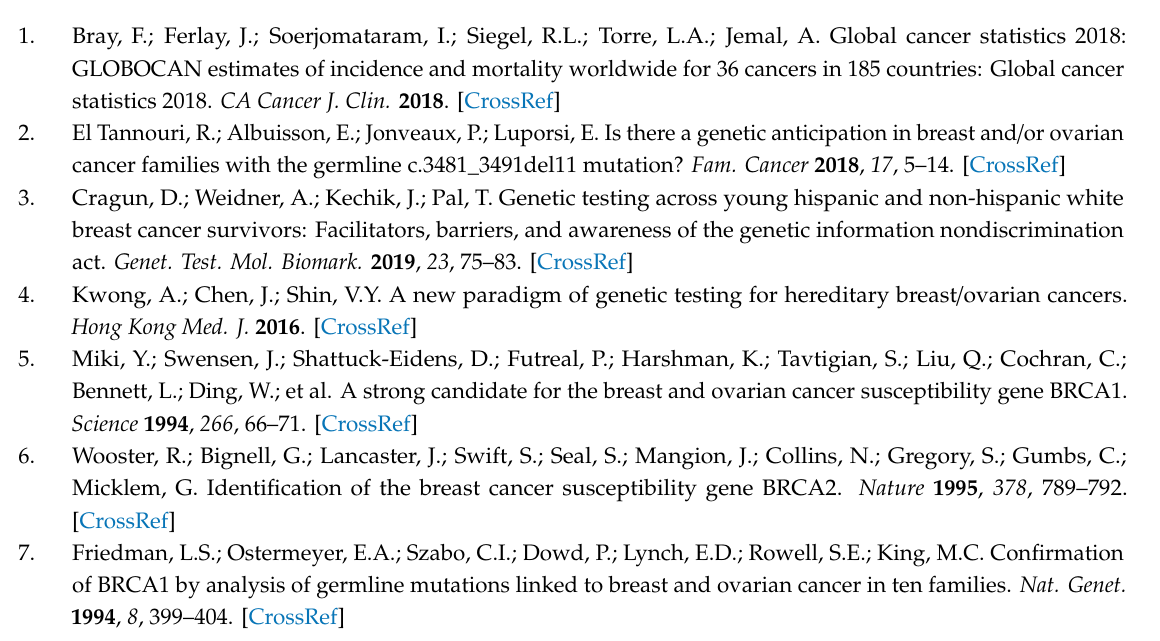
Figure S1: BRCA1 / 2 and non-BRCA gene variants reported from breast cancer cases in LA countries, Table S1: Frequent variants in non-BRCA genes in LA and their pathogenic